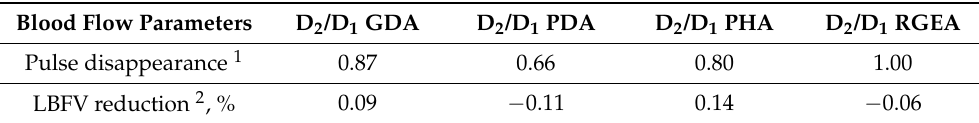
Table 7. The correlation dependence between blood flow parameters and relative arterial geometry changes.